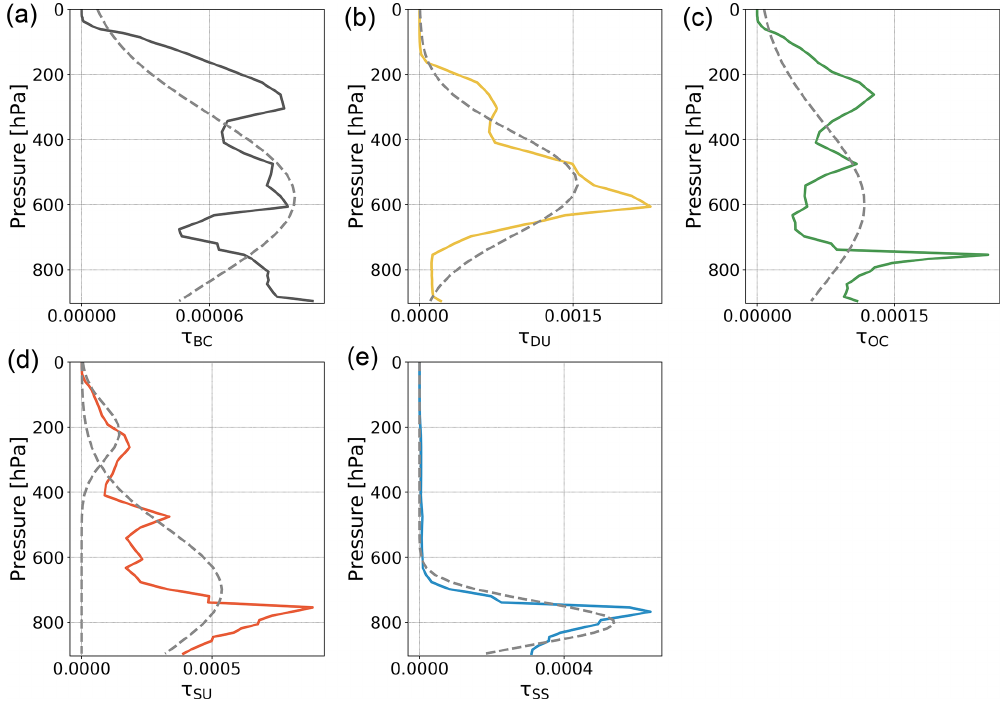
Figure 5. Example of fitting Gaussian distributions to the GEOS-5 AOD profiles. Panel (a) is black carbon, panel (b) is dust, panel (c) is organic carbon, panel (d) is sulfate, and panel (e) is sea salt. Dashed grey lines are the Gaussian fits to the profiles. Table 2. Prior uncertainties of retrieved natural log of the optical depth, σ τ , and retrieved Gaussian heights, σ H , for all retrieval variants. The first entry (V8 + MERRA-2 climatological types and AODs with high uncertainty) is equivalent to the operational ACOS retrieval uncertainties. The prior 1 σ uncertainties on the natural log of the stratospheric AOD are slightly lower, at 1.8, 0.45, and 0.001 for the three uncertainty levels,